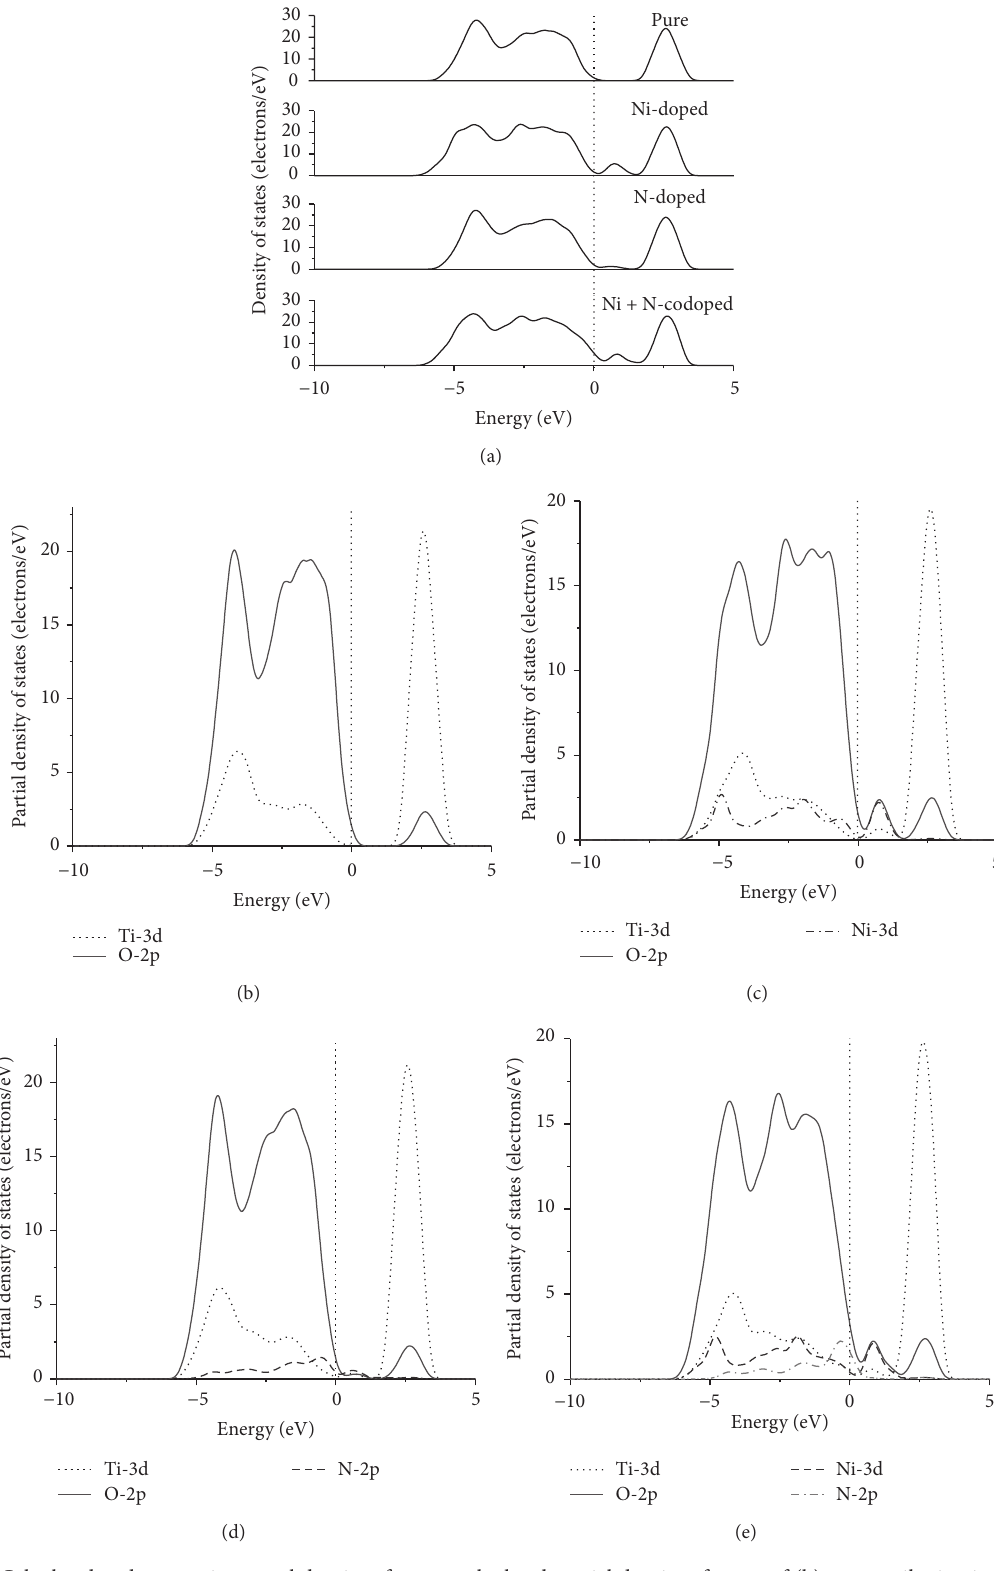
Figure 3: (a) Calculated and comparison total density of states; calculated partial density of states of (b) pure rutile titanium dioxide, (c) Ni-doped rutile titanium dioxide, (d) N-doped rutile titanium dioxide, and (e) Ni + N-codoped rutile titanium dioxide. The dot line at zero point energy is Fermi